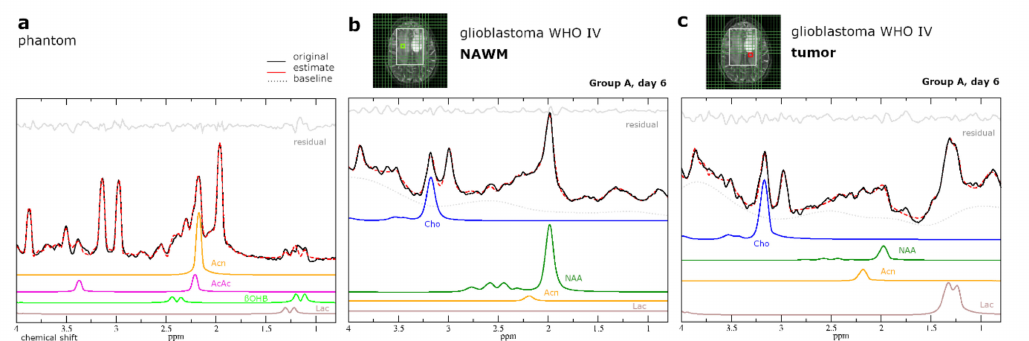
Figure 3. ( a ) Simulated dataset tested on phantom data containing β OHB 1 mM, Acn 1 mM, AcAc 1 mM, Lac 2 mM, and standard metabolites at expected in vivo concentrations. ( b , c ) Analysis of patient proton MRSI data (both Patient 38) at day 6 during crKD-IF using LCModel with simulated KB and standard metabolites, as well as a build in basis data set for simulation of MM and lipids. For visualization, a line broadening of 3 Hz was applied to all spectra. Green (NAWM) and red (tumor) boxes indicate voxel positioning on T2-weighted imaging (T2WI). The tumor voxel shown ( c ) was excluded from analysis due to insu ffi cient spectral quality, but shown here to demonstrate the di ffi culty of data evaluation in these heavily pretreated patients with recurrent high-grade glioma and ongoing re-irradiation therapy. The small Acn signal in the spectrum is comparable to the baseline modulations due to other strongly coupled metabolites, lipids, and macromolecules and this di ffi cult to ascertain visually.